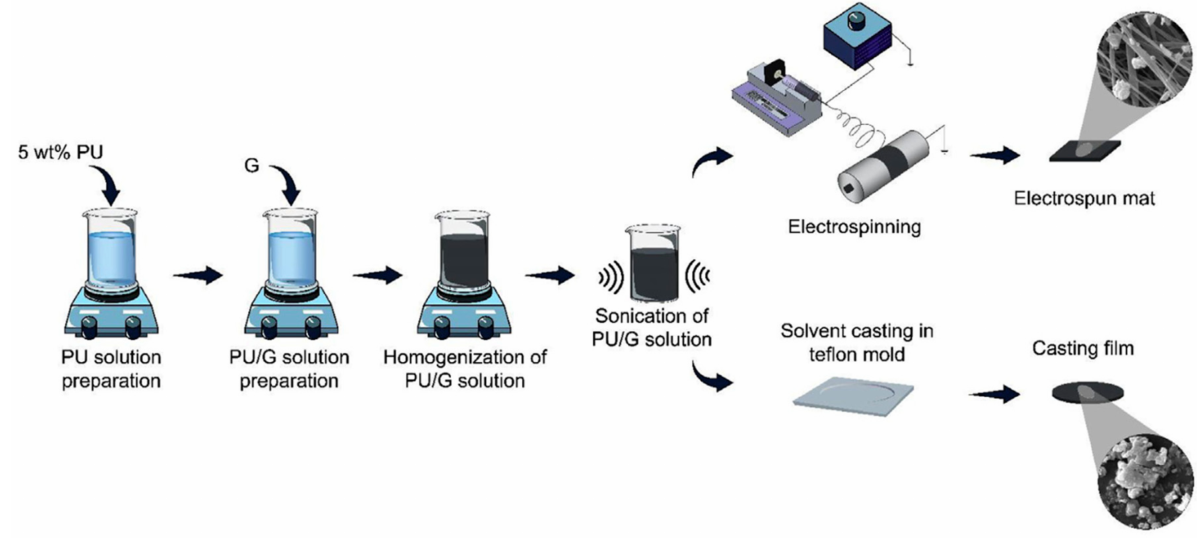
Figure 5. The fabrication techniques to create the PU/multilayer graphene flakes